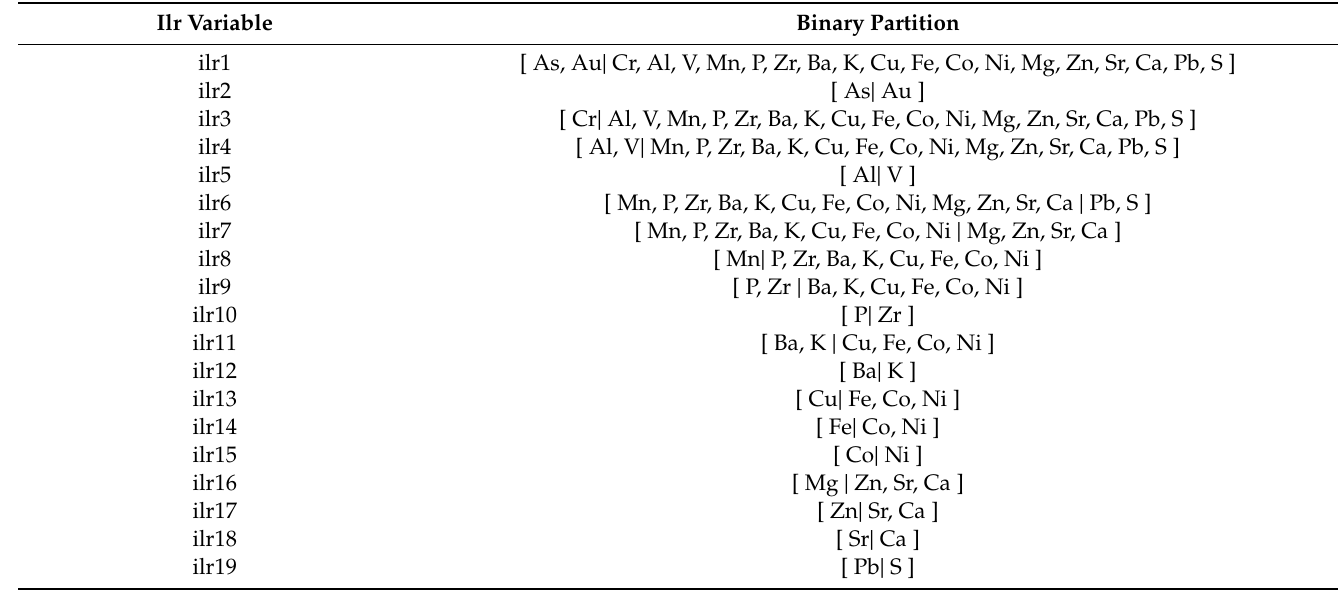
Table A3. Isometric log-ratio (ilr) variables or coordinates, defined by balances of the 20-element subcomposition of the fresh rock data subset. Balances are based on sequential binary partitioning of hierarchical clustering